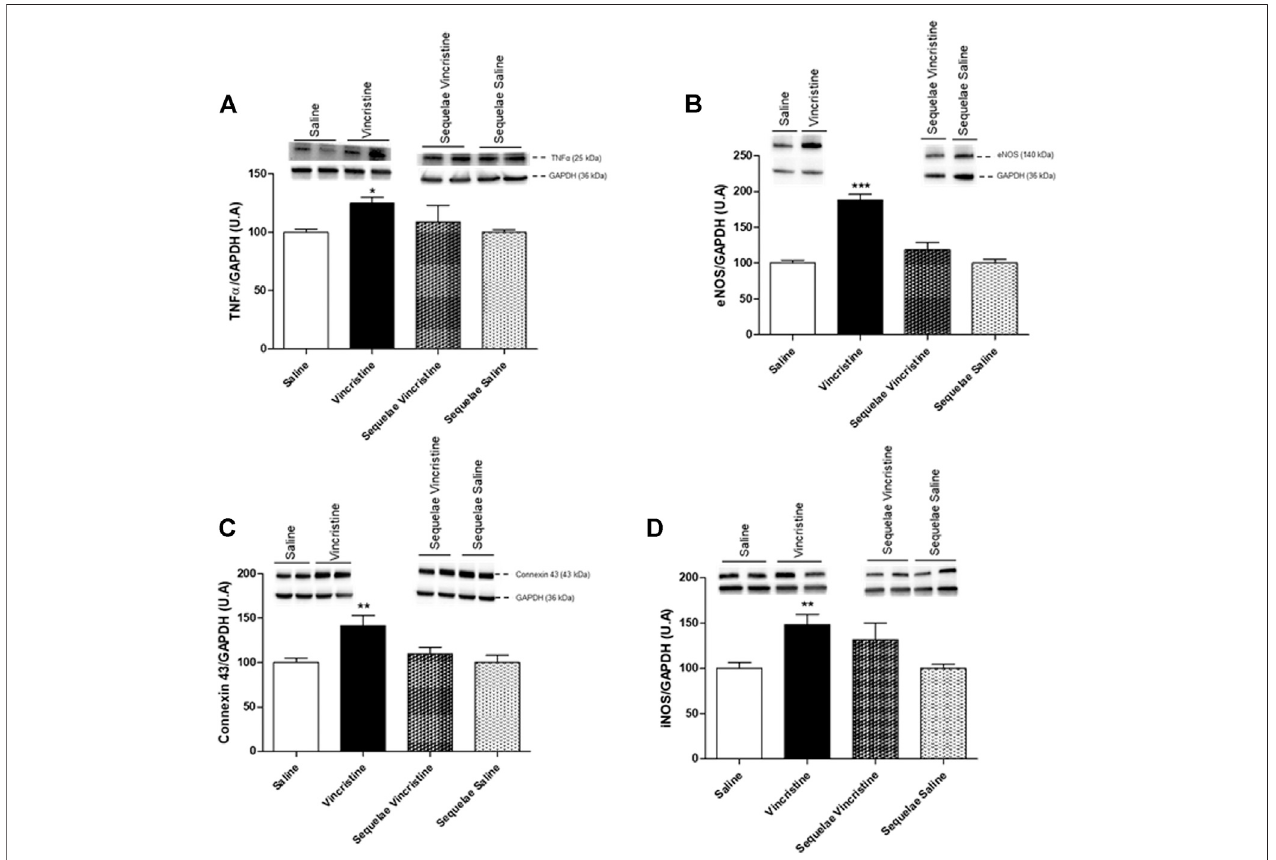
FIGURE 7 | Effect of vincristine treatment and two weeks post-treatment (sequelae) on TNF α (A) , eNOS (B) , connexin 43 (C) , and iNOS (D) protein expression in the left ventricle. Representative western blots show bands during vincristine treatment and 2 weeks post-treatment (sequelae). Densitometric evaluations of protein levels were obtained from 4 – 6 different animals. Data represent the mean ± SEM. Saline vs. vincristine (* p < 0.05, * p < 0.05 and *** p < 0.001).